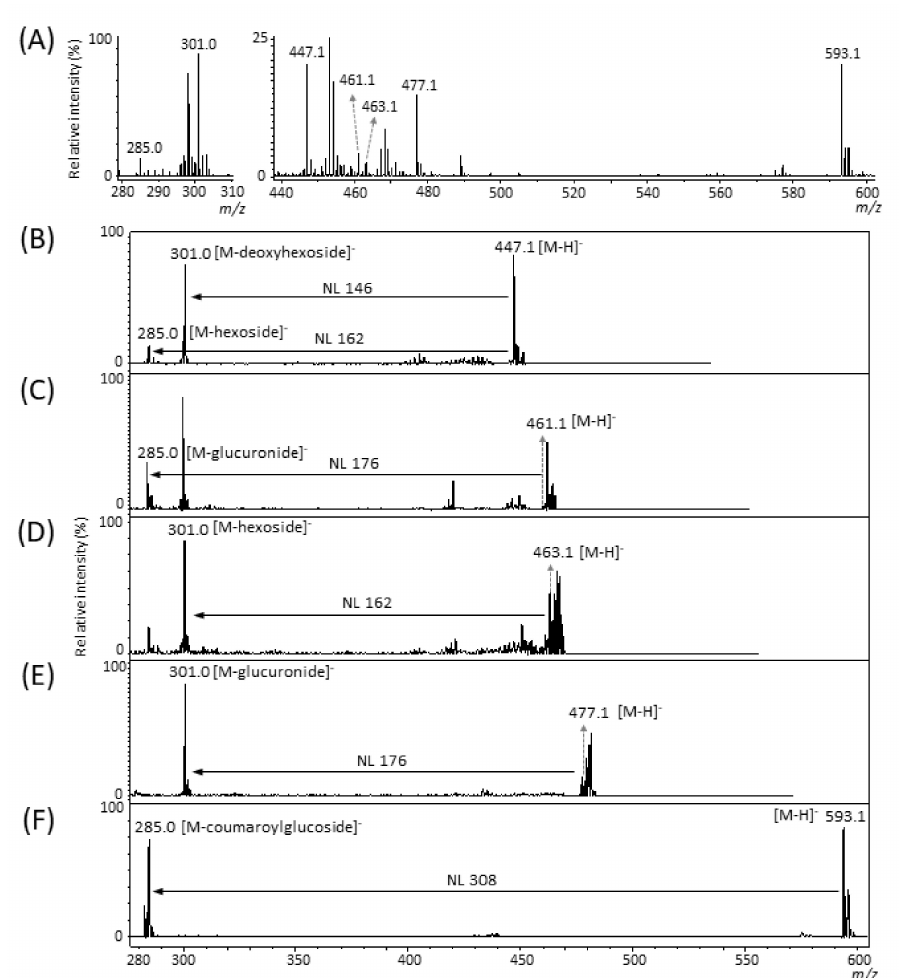
Figure 1. Tandem mass spectra of tentatively identified flavonols and ellagic acid glycosides in ripe strawberry fruit extract obtained by matrix-assisted laser desorption / ionization (MALDI)-tandem mass spectrometry (MS / MS). Mass spectrum of the extract at ( A ) m / z 280–310 and 440–600 by MALDI-MS. The m / z values indicate that the peaks were possibly attributable to flavonols and ellagic acid glycosides. MS / MS spectra of precursor ions at m / z ( B ) 447.1, ( C ) 461.1, ( D ) 463.1, ( E ) 477.1., and ( F ) 593.1. Neutral losses (NL) indicate the losses of sugar